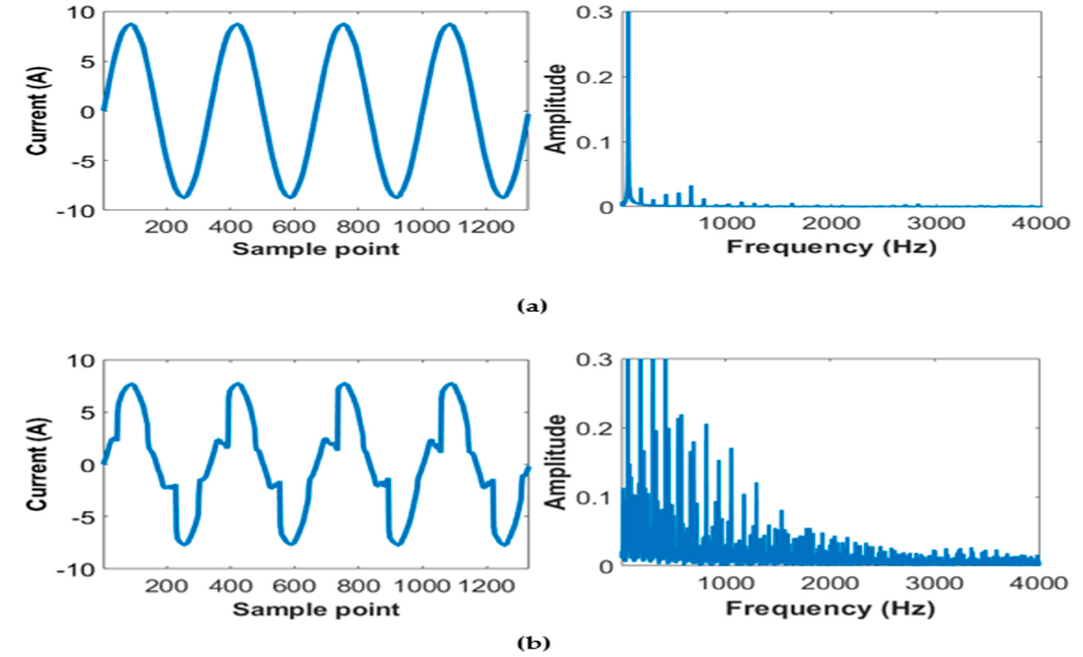
Figure 3. Measurement results for toaster ( a ) normal state , ( b ) arc fault state.